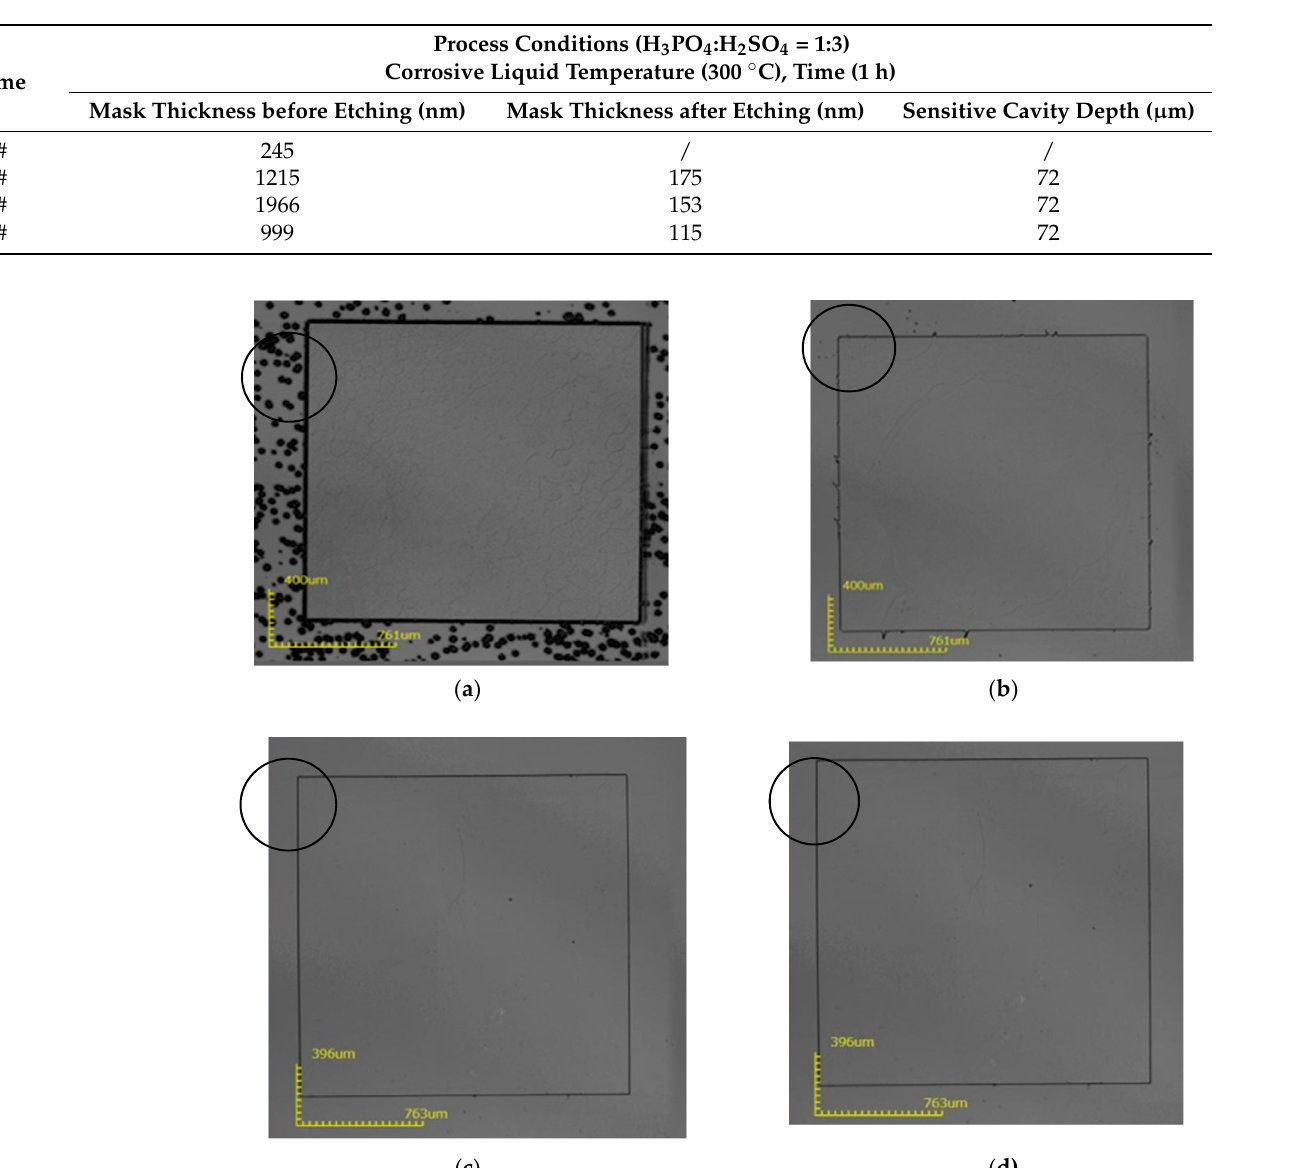
Table 2. Process results at 200 °C.